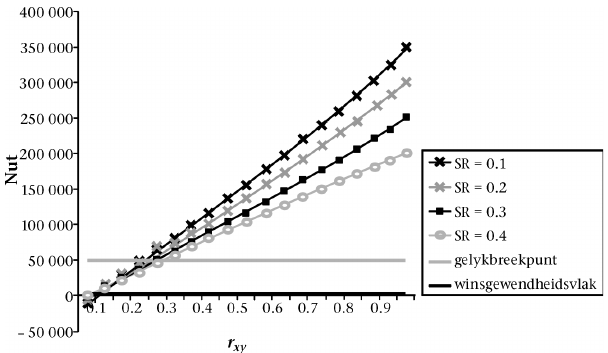
Figuur 3: Die nut per geselekteerde as ‘n funksie van die waarde van die geldigheidskoëffisient en die seleksieratio